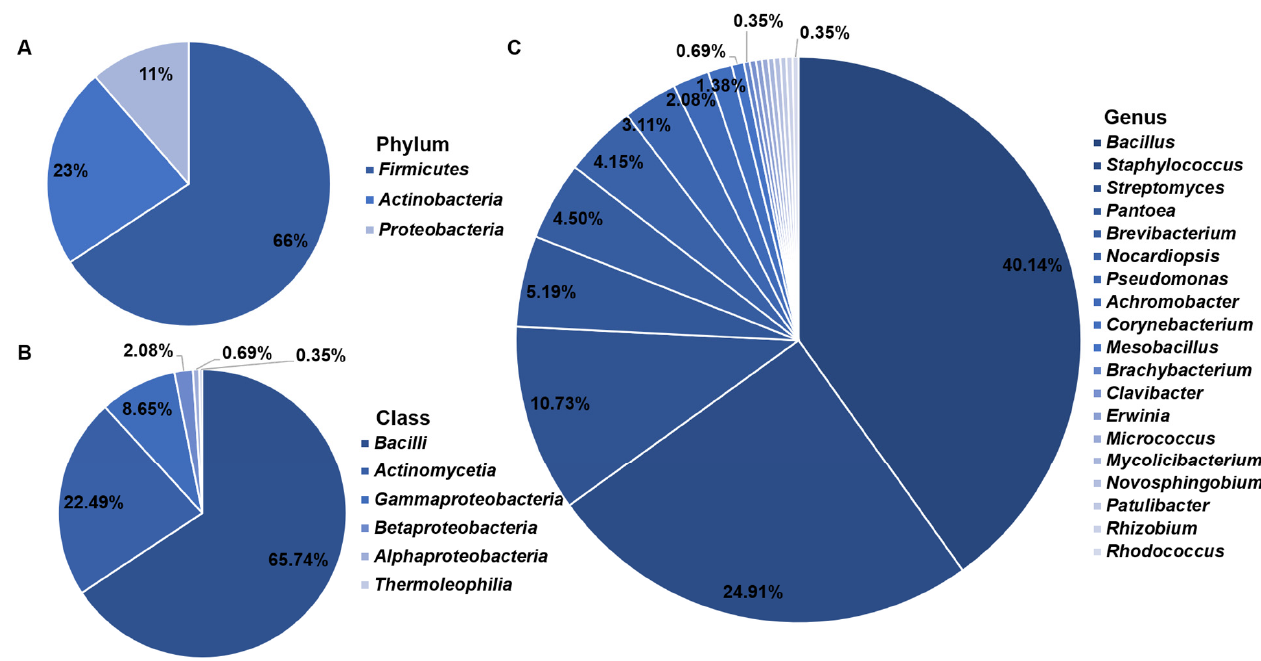
Figure 1. The percentage of endophytic bacterial isolates isolated from nine halophytic samples in the western Aral Sea at the phylum ( A ), class ( B ), and genus ( C ) level.